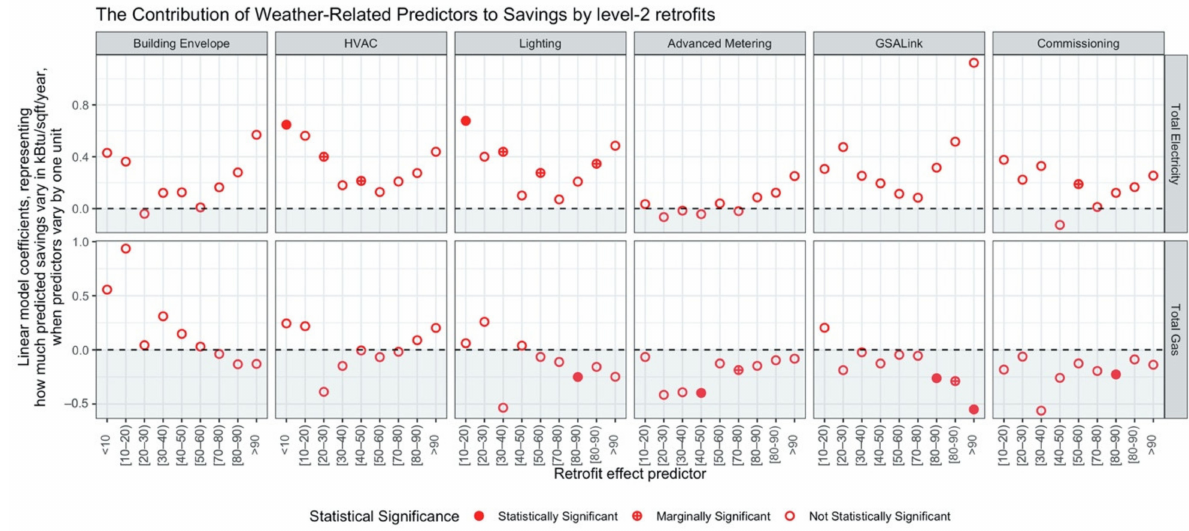
Figure 18. The contribution of weather-related predictors to the savings prediction of electricity and gas savings of six